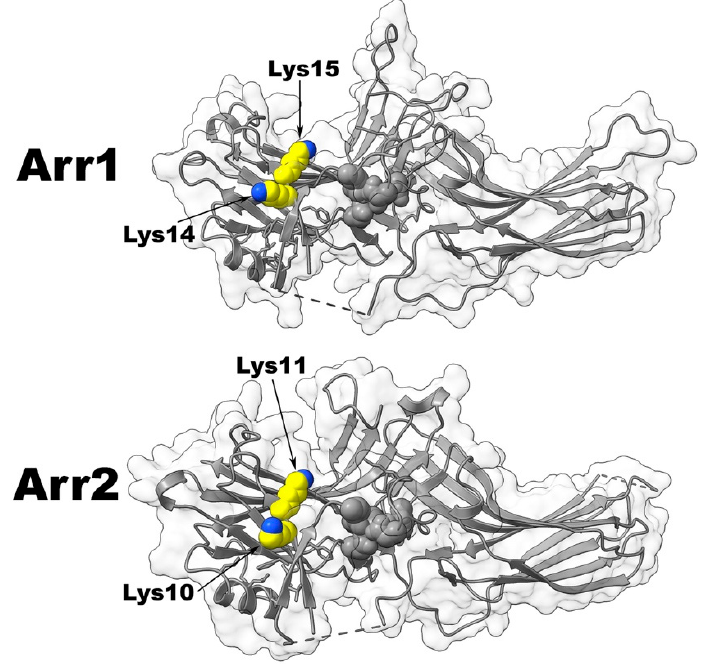
Figure 3. Two lysines in β -strand I of arrestins. Upper panel. The structure of basal bovine arrestin- 1 (PDB ID: 1CF4 [24]) with the two β -strand I lysines shown as CPK models. Nitrogen in the amino group is shown in blue, carbon atoms in yellow. Lower panel. The structure of basal bovine arrestin-2 (PDB ID: 1G4M [25]) with the two β -strand I lysines shown as CPK models. Nitrogen in the amino group is shown in blue, carbon atoms in yellow. Arr1—arrestin-1, Arr2—arrestin-2.